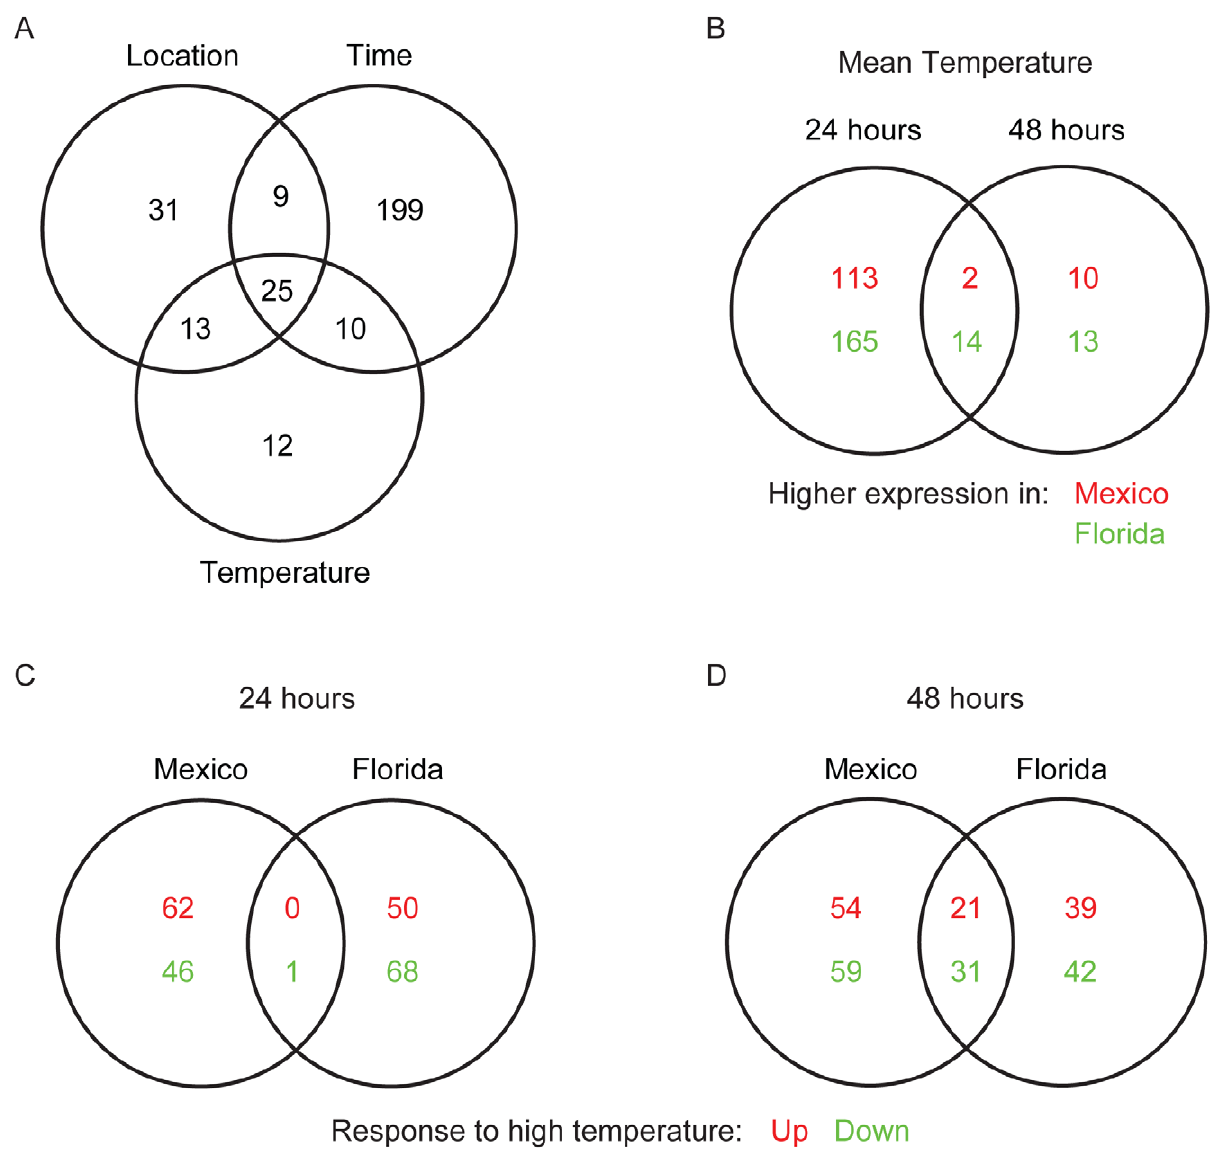
Figure 4. Overlap among differentially expressed genes in M.faveolata embryos from Florida and Mexico. ( A ) Differentially expressed genes (DEGs) responding to all three main effects of location, time and temperature were identified (note the large number of genes responding to the effect of developmental time). ( B ) When raised at control water temperatures the number of genes that were differentially expressed between the two locations was high at 24 hours, but dropped sharply by 48 hours. ( C ) DEGs responding to temperature differences show almost no overlap between locationsat 24 hours (0 up,1 down), but ( D ) considerableoverlapby 48 hours. In B , upperandlower valuesindicate higher expression in Mexico relative to Florida. In C and D , upper and lower values indicate higher and lower expression levels respectively, under thermal stress conditions.